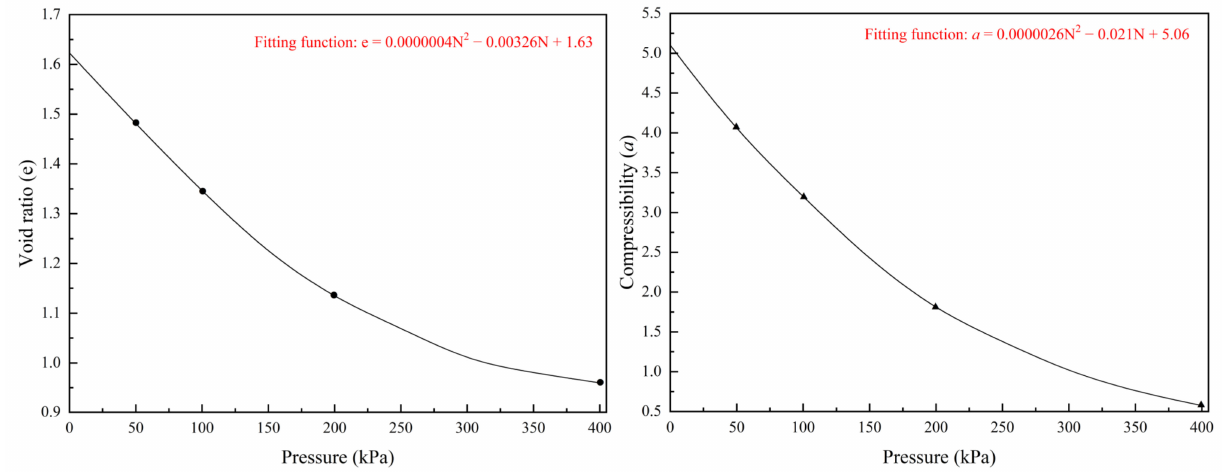
Figure 9. Void ratio, compression coefficient, and load relation curves.